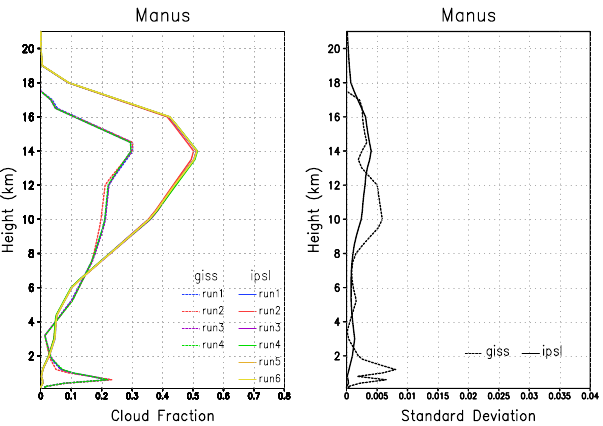
Fig. 15. The vertical profiles of cloud fraction (CF) for four GISS and six IPSL ensemble simulations (left), and their standard devia- tions (SD, right) among ensemble runs over